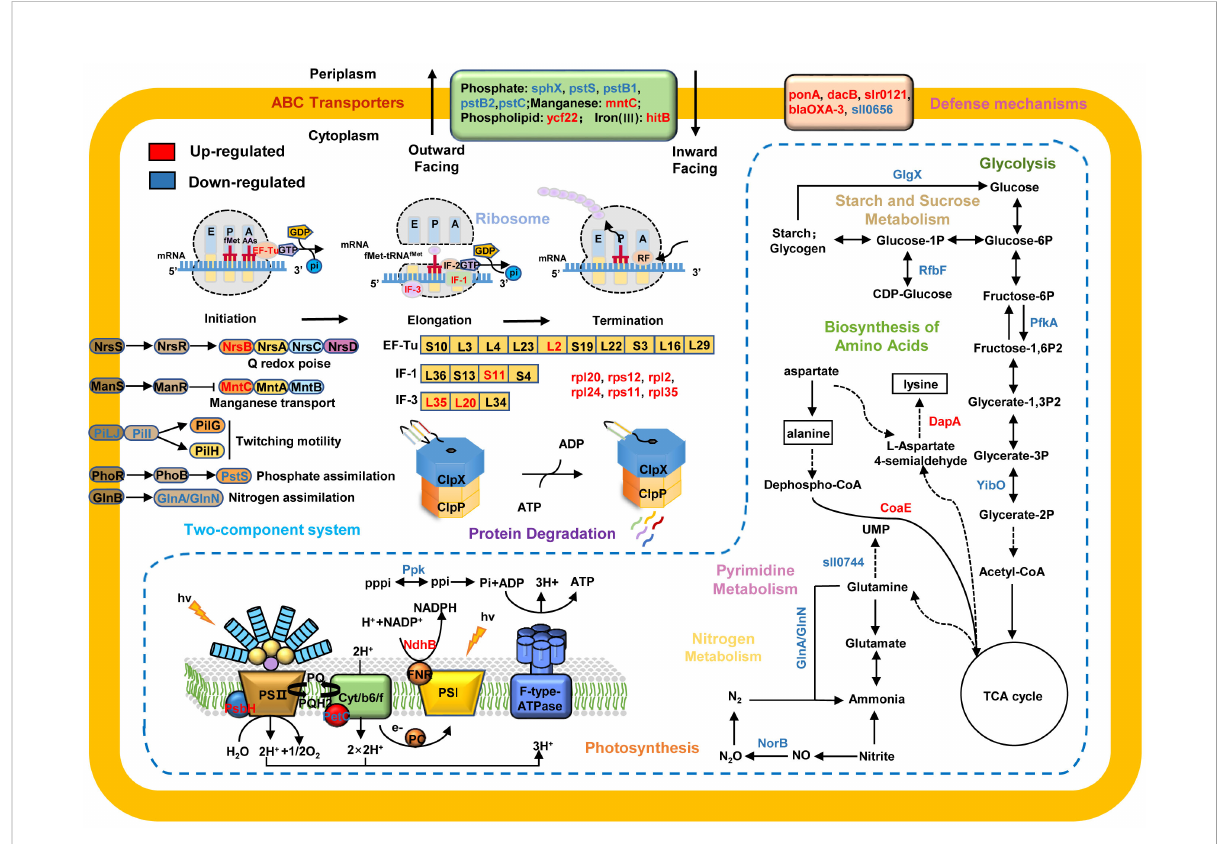
FIGURE 6 A proposed model showing the regulatory networks of ClpX in Synechocystis sp. PCC 6803. The upregulated proteins are highlighted in red and downregulated proteins are in blue. Arrows represent state transitions or metabolite fl